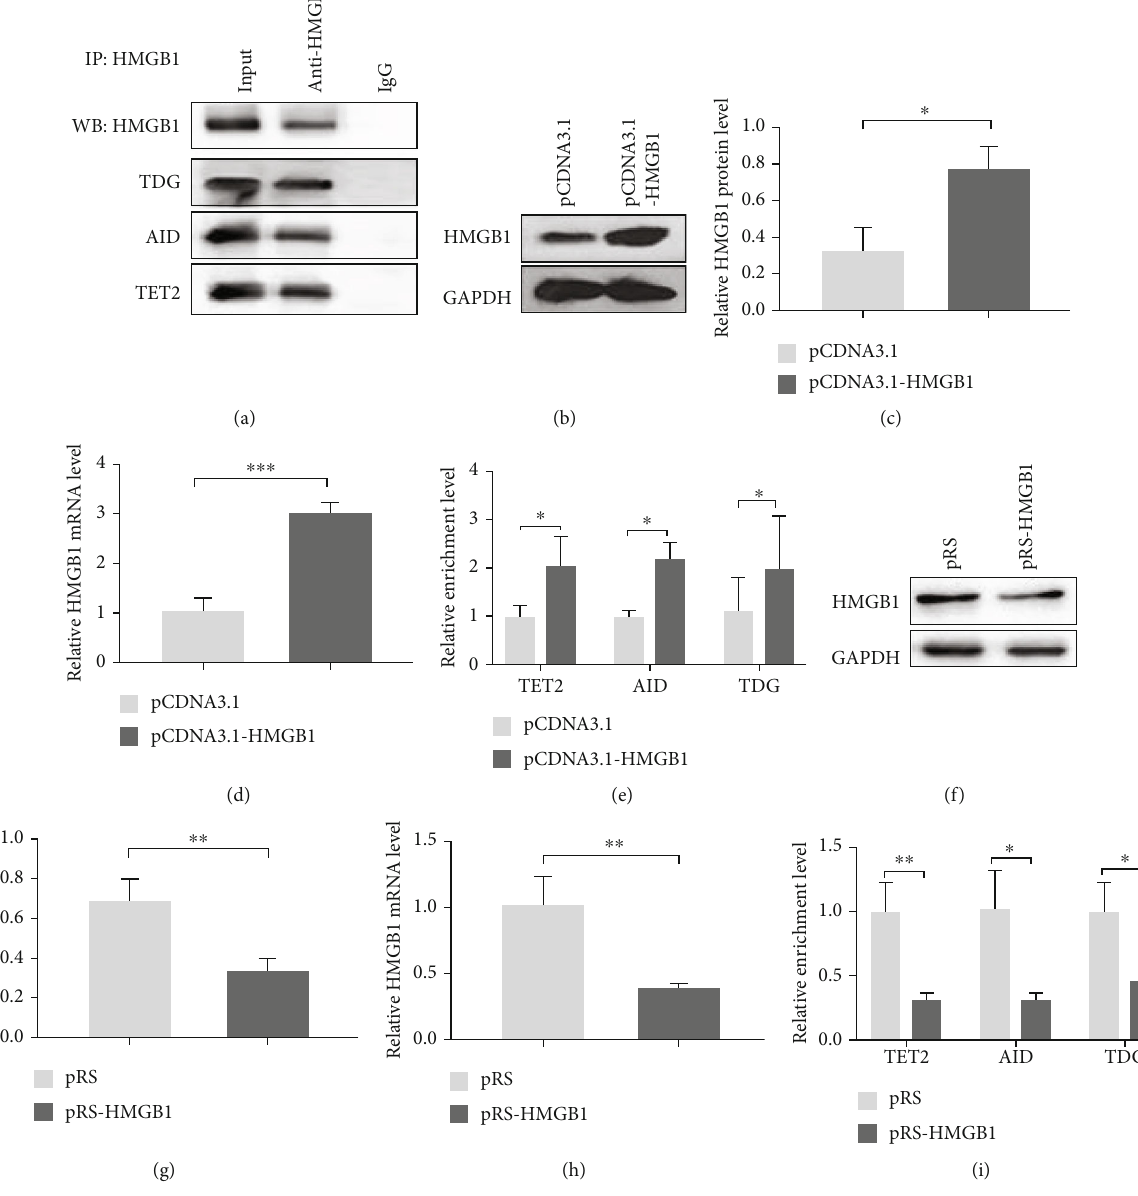
Figure 4: HMGB1 recruited TET2, AID, and TDG to bind to STAT3 promoter. (a) The combination of HMGB1 and TET2/AID/TDG was detected by Co-IP in Jurkat cells and analyzed by western blot analysis. (b – d) Representative western blotting results for (b) HMGB1, (c) relative HMGB1protein level, and (d) mRNA level in non-GVHD CD4 + T cells transfected with the HMGB1 overexpression plasmid or negative control plasmid. (e) The binding levels of TET2/AID/TDG in STAT3 promoter in HMGB1-overexpressed non-aGVHD CD4 + T cells and control cells. (f – i) After interference with HMGB1 in aGVHD CD4 + T cells, representative western blotting results for (f) HMGB1, (g) relative HMGB1 protein level, (h) relative HMGB1 mRNA level, and (i) the binding levels were detected. Experiments were repeated three times. Data are presented as the mean ± SD of three independent experiments. ∗ p < 0 : 05 , ∗∗ p < 0 : 01